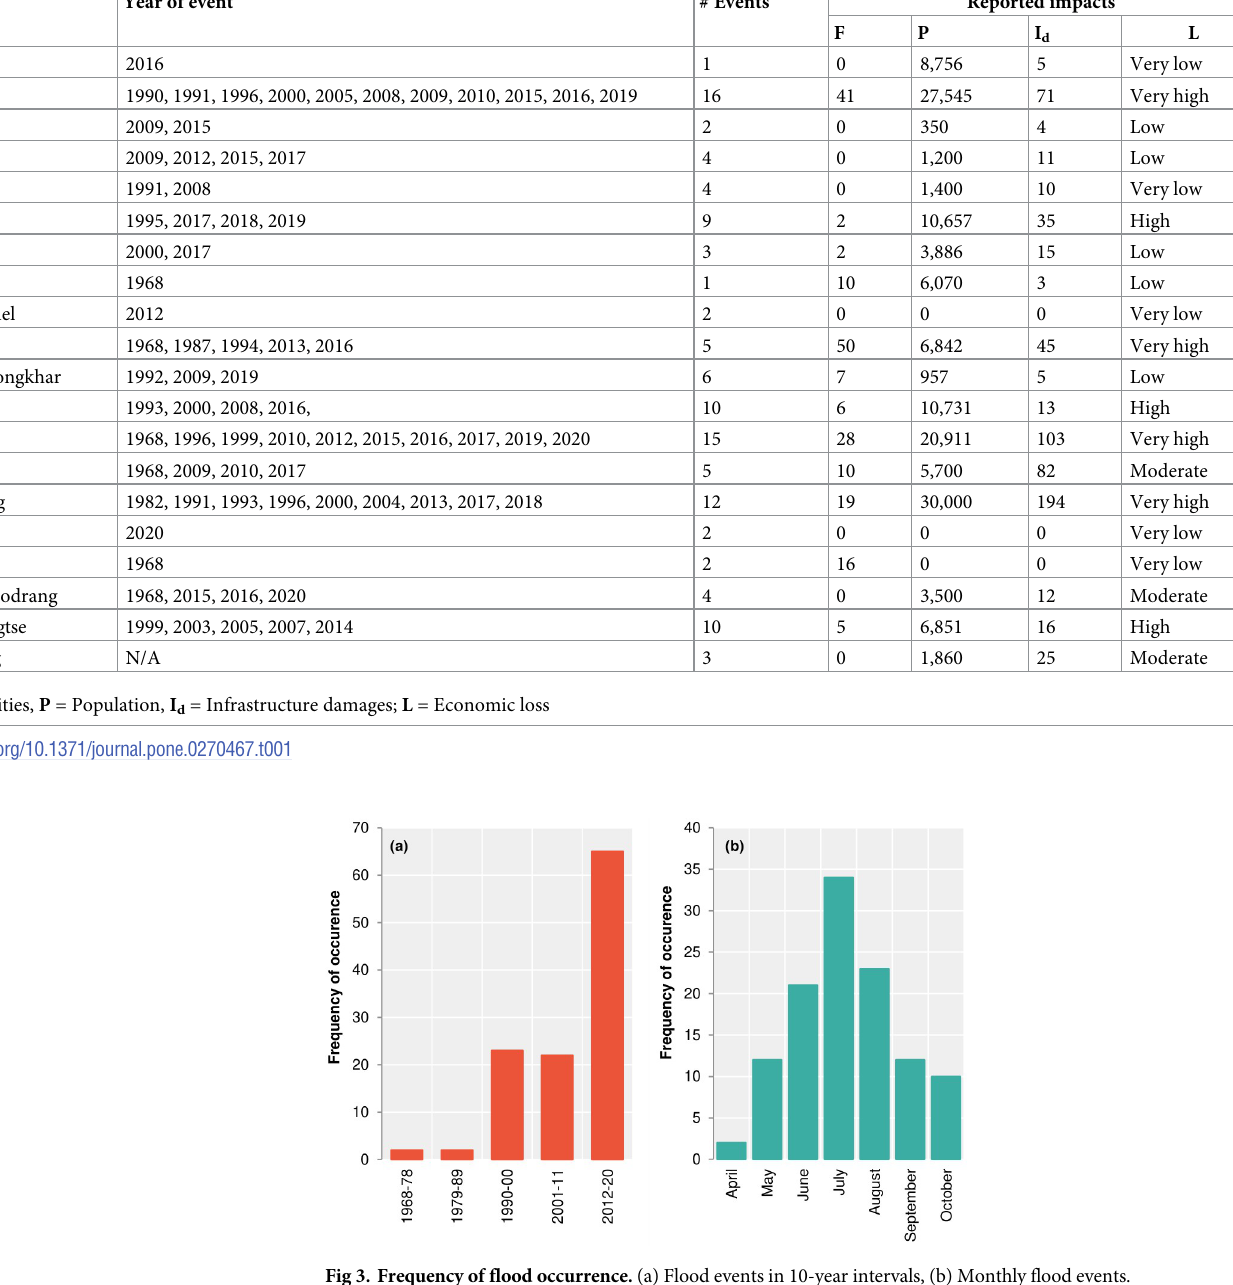
Table 1. De-clustered historical annual flood events since 1968 in 20 districts of Bhutan. District